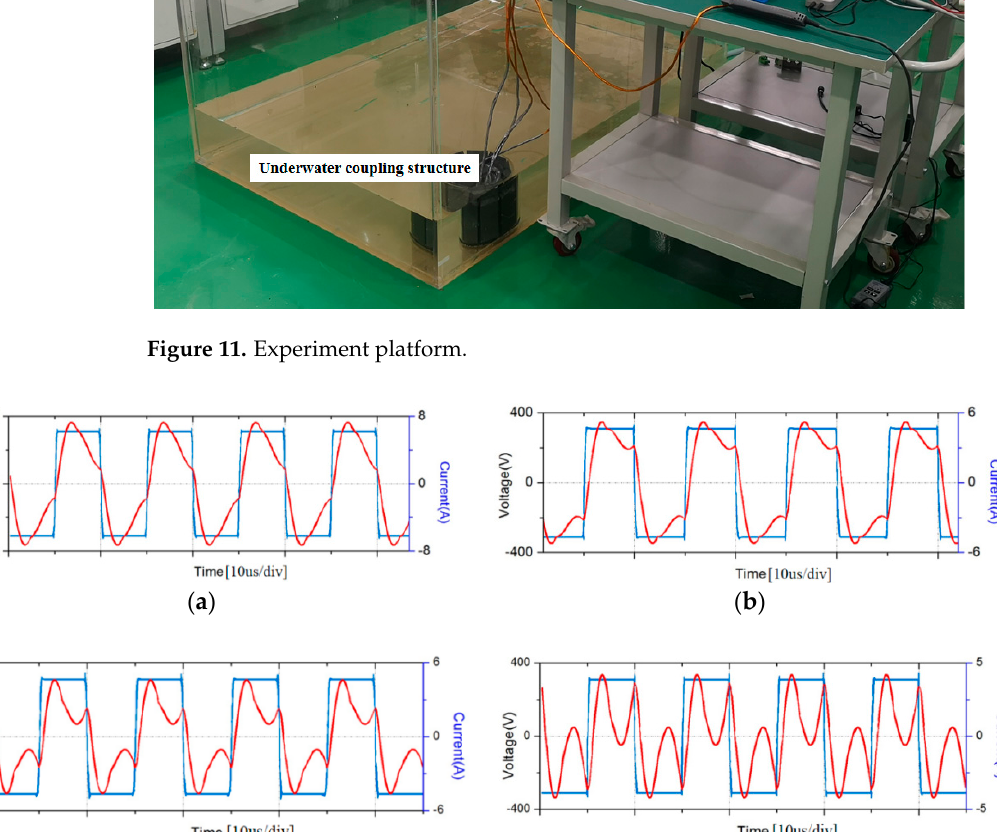
Figure 11. Experiment platform.